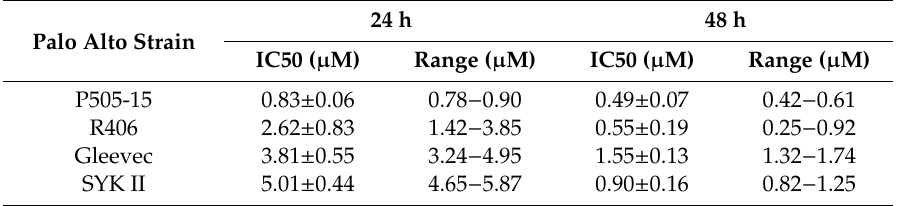
Table 2. Approximate IC 50 values for each drug were determined by treating ring-stage cultures of P. falciparum , Palo Alto strain, with di ff erent concentrations of each drug and by quantitating residual parasitemia 24 and 48 h